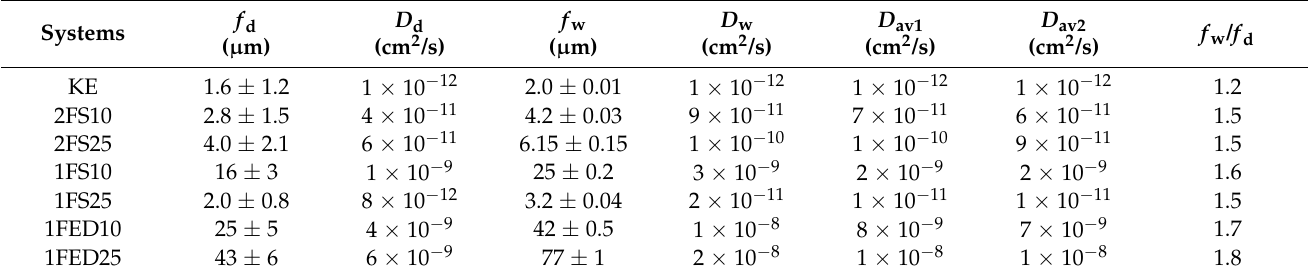
Table 4. Parameters used for the water swelling kinetics modeling.